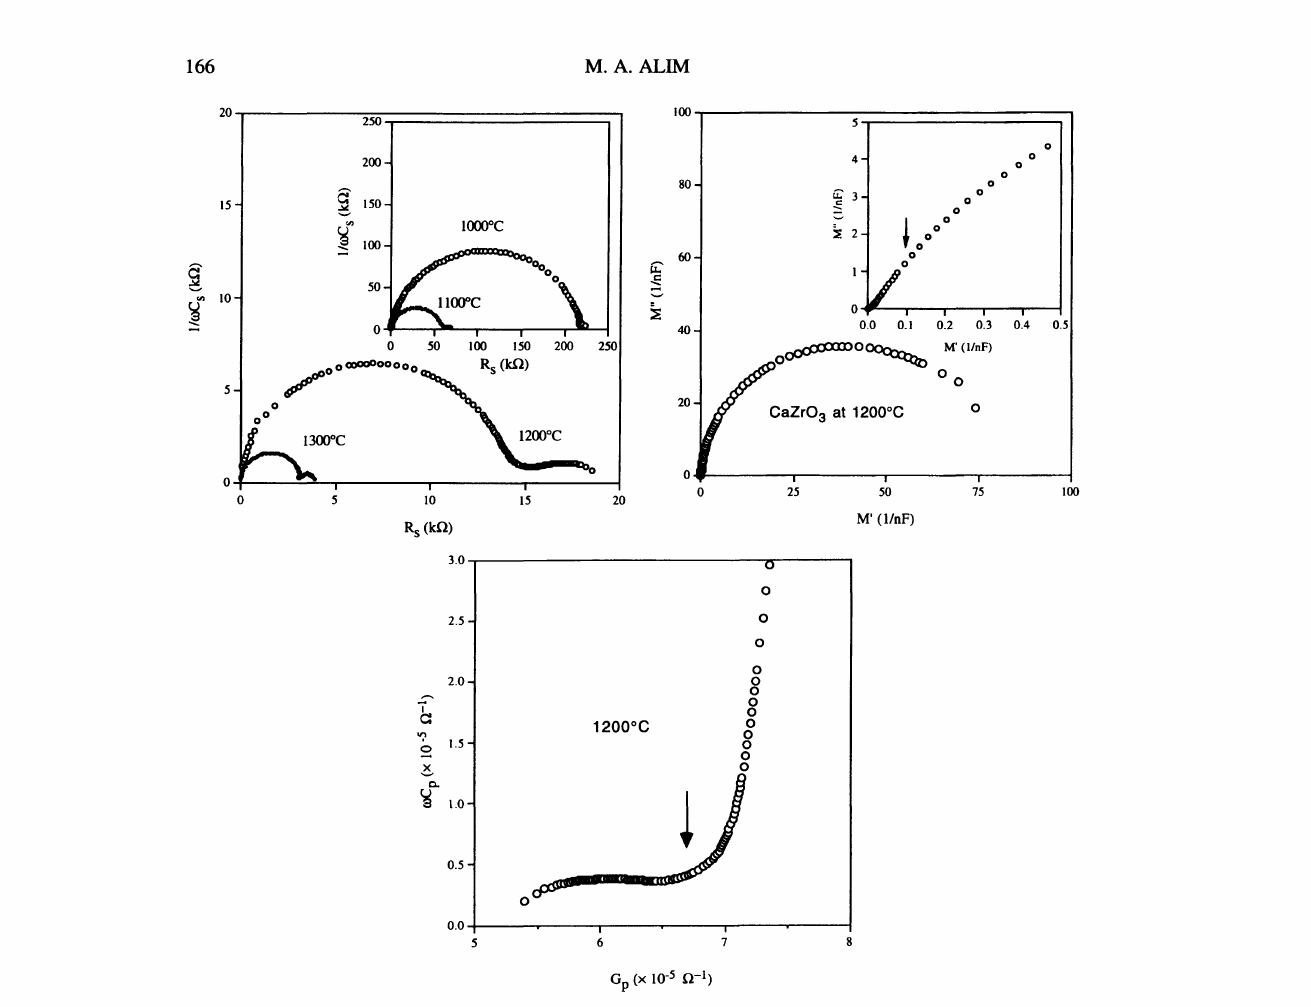
FIGURE 10 (a) Impedance plane representation of a calcium zirconate sample at four temperatures (1000C, ll00C, 1200C, and 1300C). (b) Modulus plane representation of the same sample as in (a) at 1200C. The inset highlights the demarcation with an arrow between high- and low-frequency responses documented in (a). (c) Admittance plane representation of the same sample as in (a) or (b) at